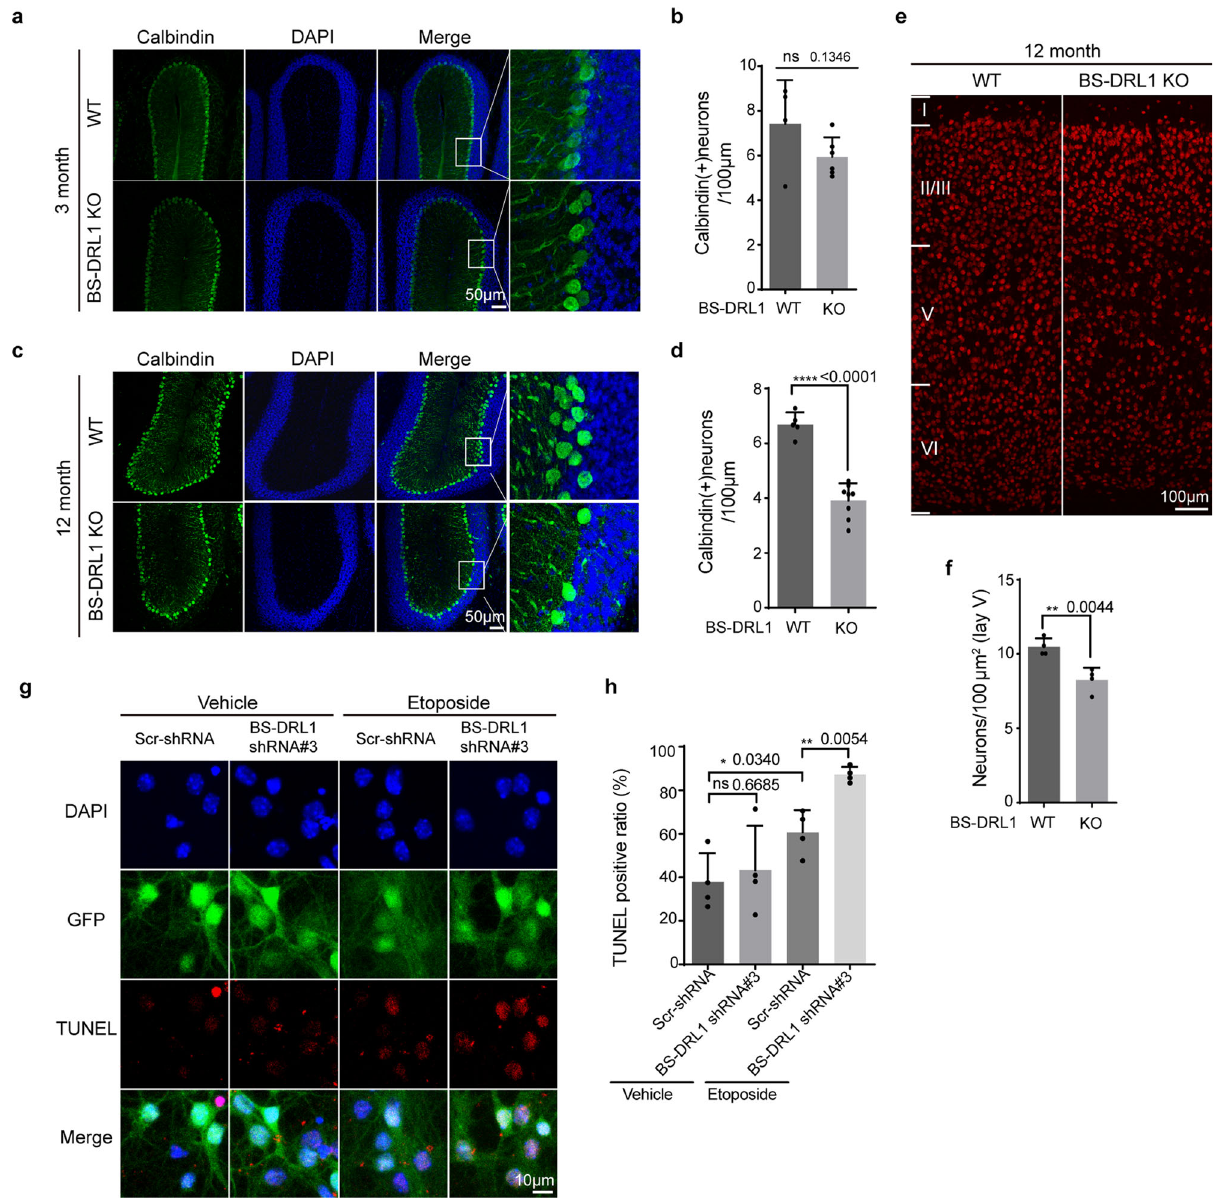
Fig. 7 BS-DRL1 KO mice show progressive Purkinje cell degeneration. a , b Representative images showing immunostaining of Purkinje cells (in green) and quanti fi cation of Purkinje cells. Immuno fl uorescence staining was performed with brain sections prepared from 3-month-old naive mice and calbindin antibody. Scale bar: 50 μ m. Data are presented as mean ± SD. For each group, n = 3. ns not signi fi cant. c , d Same as ( a , b ) except the brain sections were prepared from 12-month-old naive mice. Scale bar: 50 μ m. Data are presented as mean ± SD. For each group, n = 3. **** p < 0.0001. e , f Representative images of immunostaining and quanti fi cation for NeuN-positive neurons in M1 cortex of naive 12-month-old mice. Scale bar:100 μ m. Data are presented as mean ± SD. For each group, n = 3. ** p < 0.01. g , h TUNEL staining and quanti fi cation of neurons transduced with indicated shRNA virus and treated with vehicle or ETO for 1 h. Four images per group and 28 – 34 cells per image were used for statistic. Scale bar:10 μ m. Data are presented as mean ± SD. * p < 0.05, ** p < 0.01, ns not signi fi cant. n = 3 biologically independent